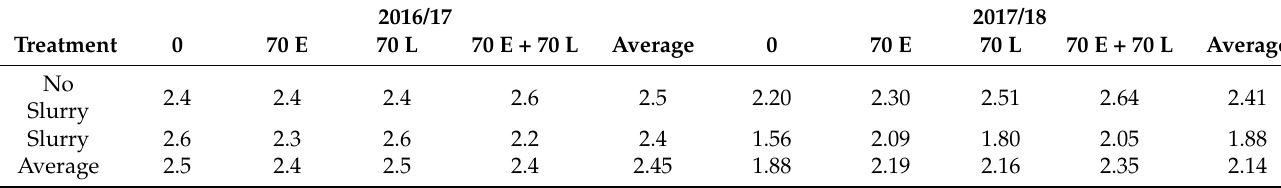
Table 7. Straw yields (t/ha) for both 2016/17 and